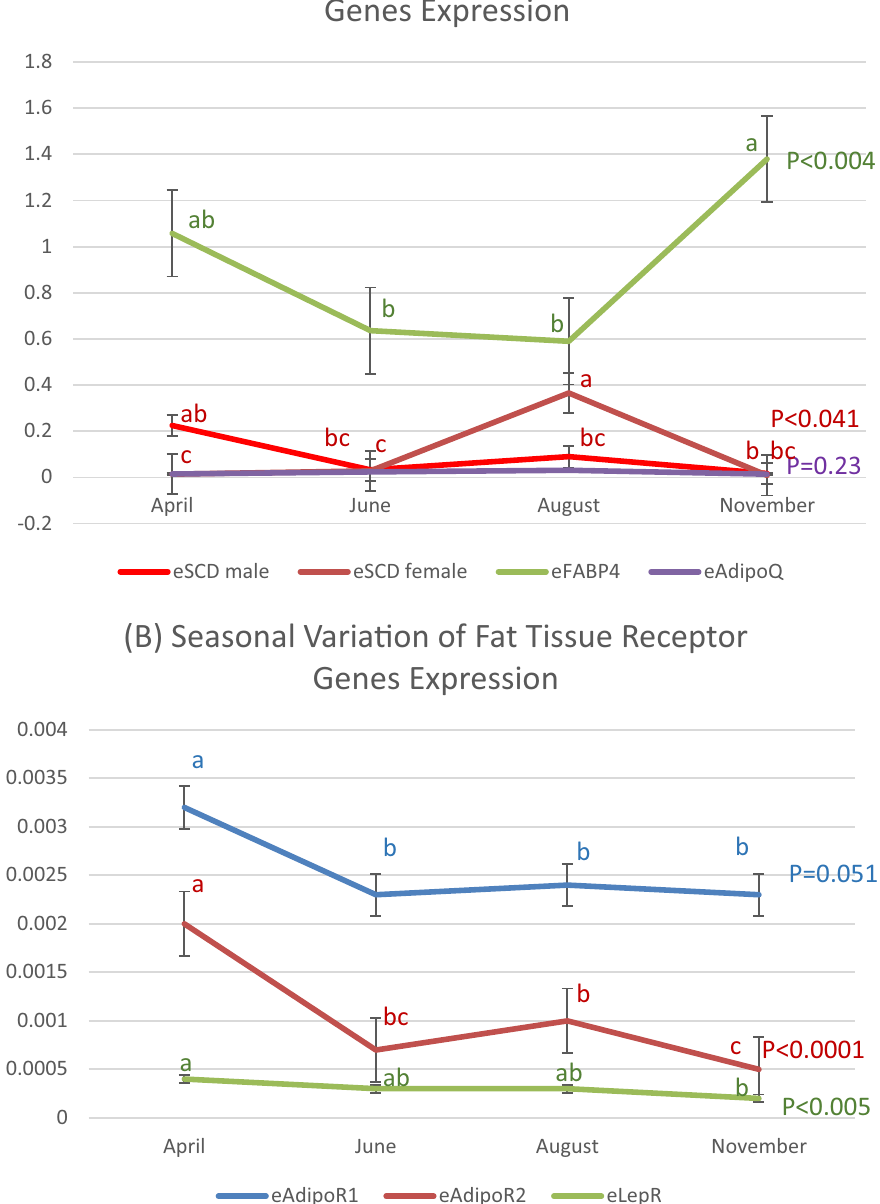
Figure 3. Seasonal variation in mRNA expression ( A ) eSCD1 , eFABP4 , eAdipoQ , ( B ) eAdipoR1 , eAdipoR2 , eLepR . eFABP4: emu Fatty Acid Binding Protein ; eAdipoQ: emu Adiponectin ; eAdipoR1: emu Adiponectin Receptor1 ; eAdipoR2: emu Adiponectin Receptor2 ; eLepR: emu Leptin